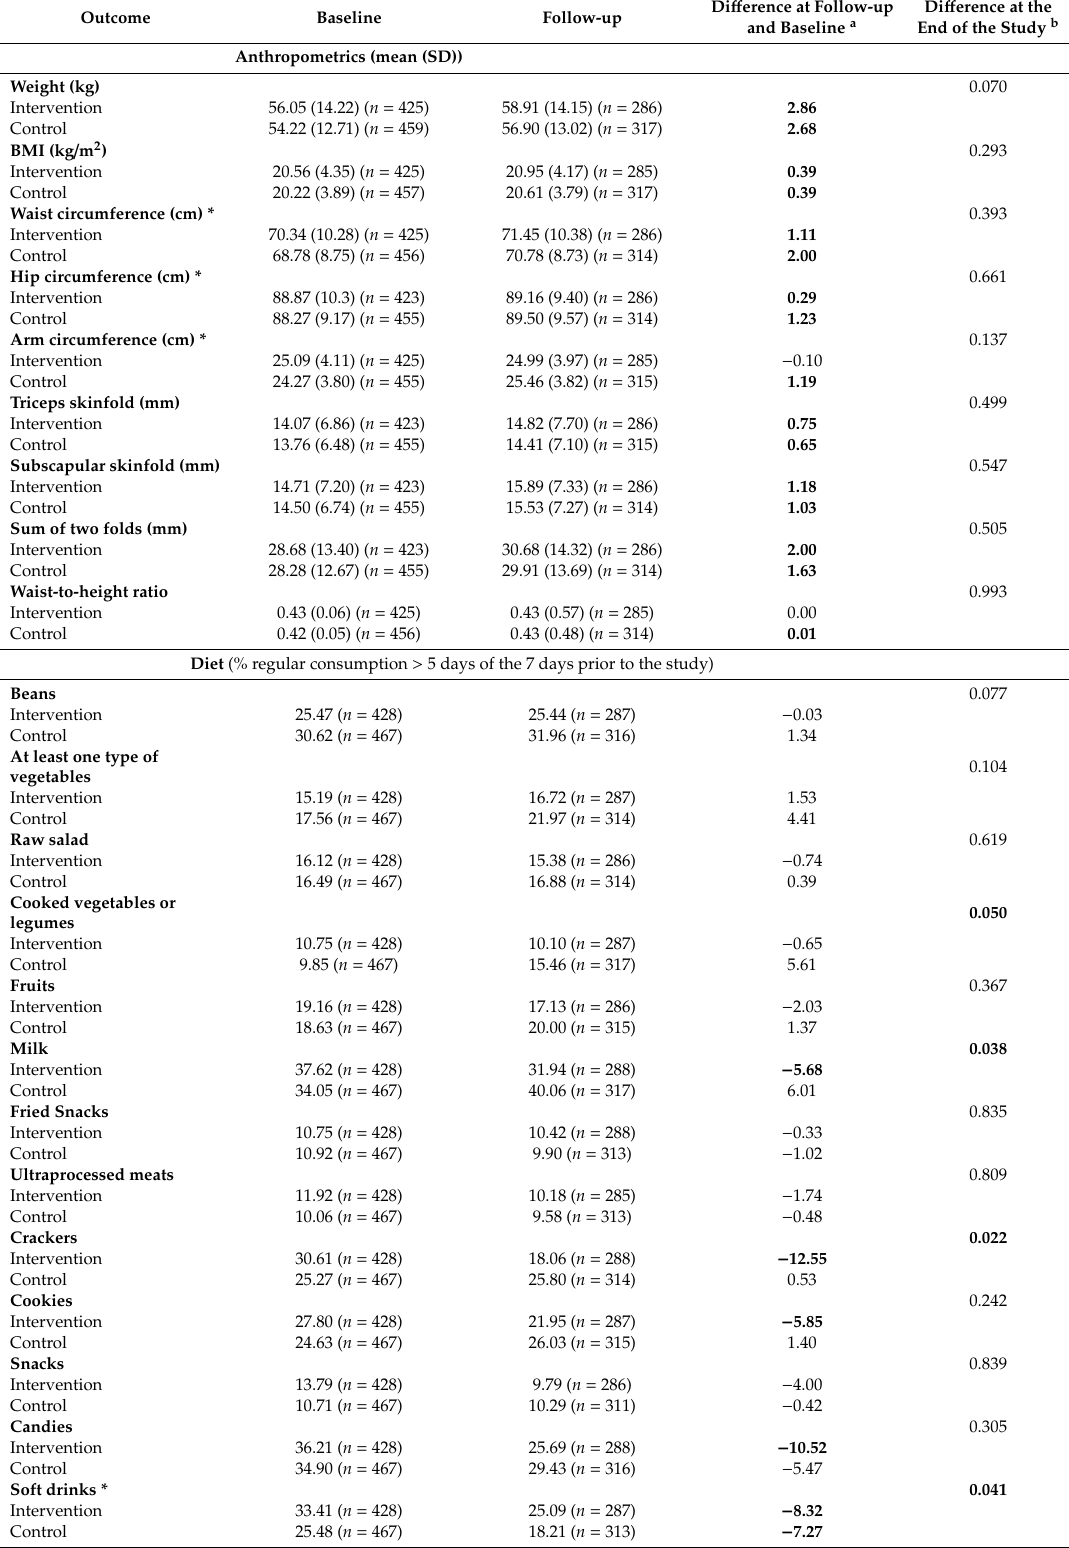
Table 4. Outcome Measures for the Intervention and Control Groups in baseline and follow-up. Salvador,